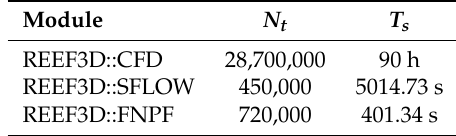
Table 7. Comparison of total number of cells N t and simulation time T s in seconds for the simulation of wave propagation over a submerged bar using the three